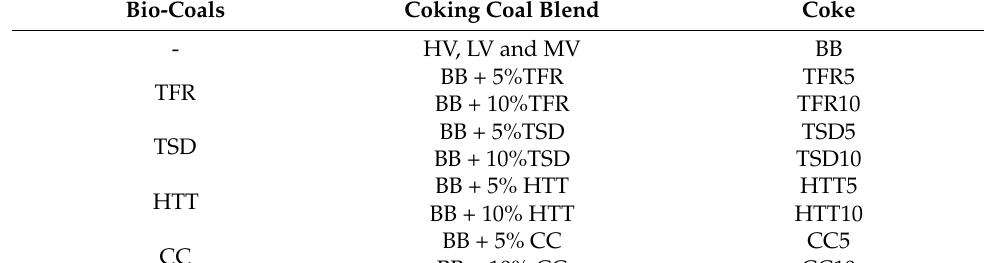
Table 5. Added bio-coals and abbreviations of coking coal blends for carbonization in the Tamman furnace and the produced cokes.